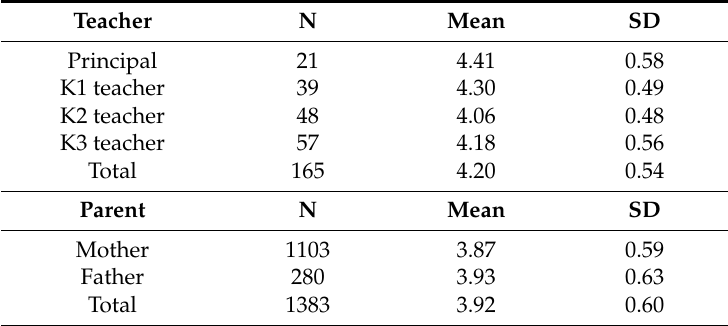
Table 3. Mean (SD) values for teachers’ and parents’ SWB.